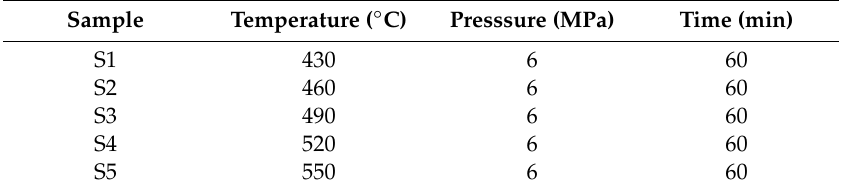
Table 2. Di ff usion bonding parameters in the present